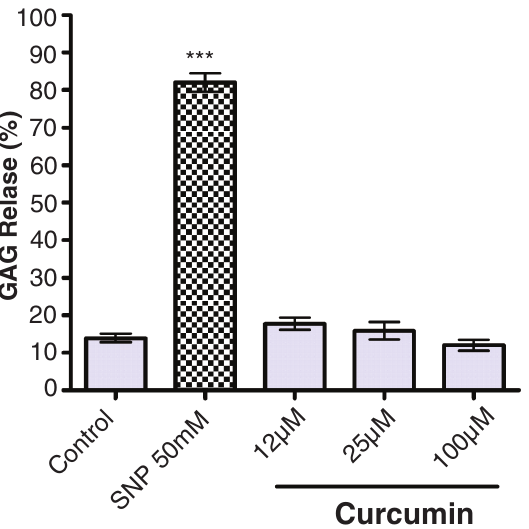
Figure 3. Effect of curcumin on proteoglycan (PG) release from unstimulated cartilage explants. Control column indicates cartilage discs incubated in the culture medium alone. Values are reported as the mean of three animals per treatment ± SEM. Data are from 3 different animals, with three technical replicates per animal. Significance compared to control is indicated by *** ( p <0.001). Sodium nitroprusside (SNP) (50mM) significantly increases PG release compared to control ( p <0.001). Curcumin does not alter PG release from the explants compared to control at concentrations of 12μM, 25μM or 50μM. PG loss is expressed as sulfated glycosaminoglycan (GAG) release.